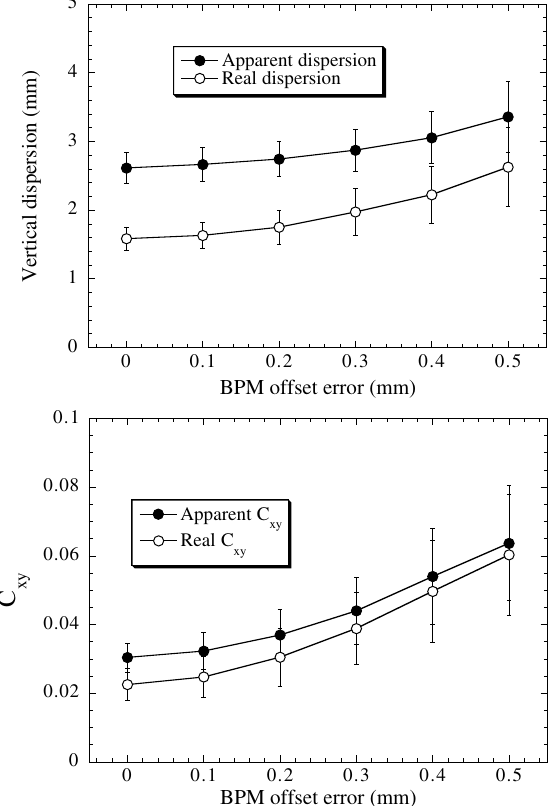
FIG. 11. Averages of (top panel) (cid:3) and (cid:3) , (bottom arc ; meas arc and C vs (cid:27) after the coupling correction. The panel) C ) xy meas xy a a error bars indicate the standard deviations.